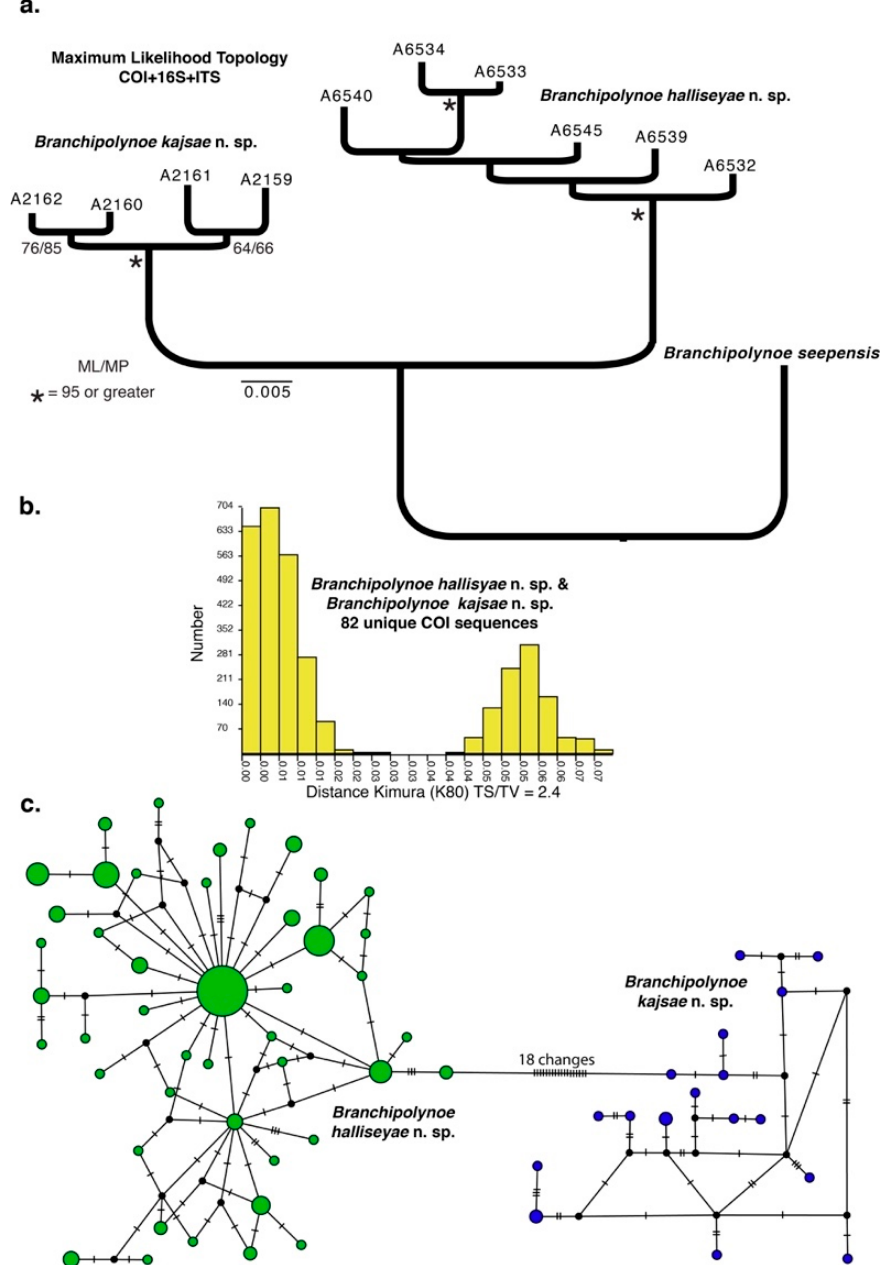
Figure 2. ( a ) Maximum likelihood (ML) tree from combined COI, 16S, and ITS for a subset of Branchipolynoe halliseyae n. sp. and B. kajsae n. sp. specimens, rooted with B. seepensis . ( b ) Automated barcode gap definition (ABGD) plot [54] of pairwise distances for 82 unique COI sequences for all 144 COI sequences for B. halliseyae n. sp. and B. kajsae n. sp.